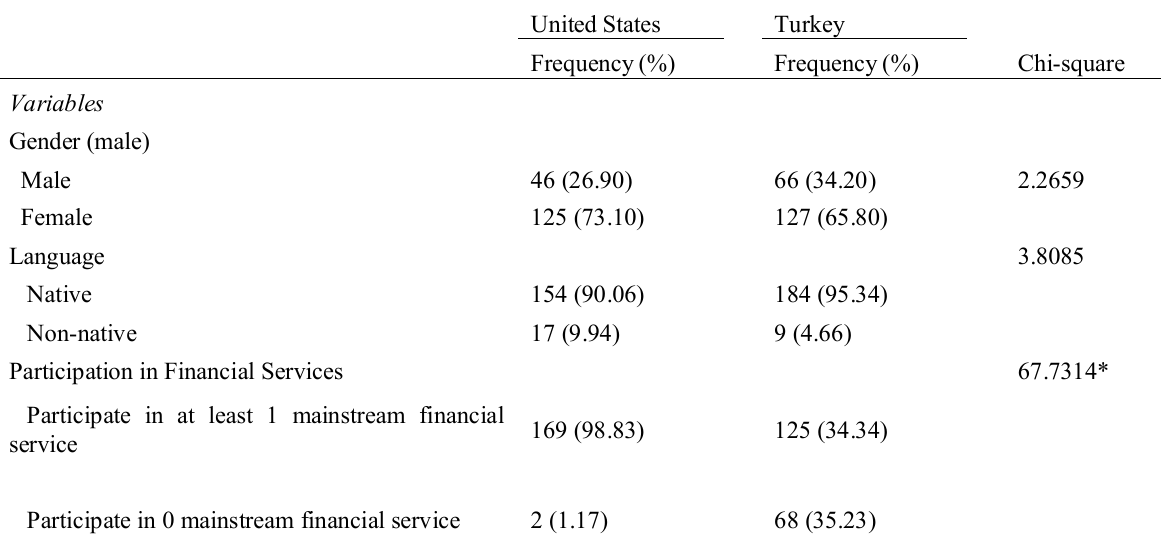
Table 1. Frequency and Bivariate Analysis Results for Independent